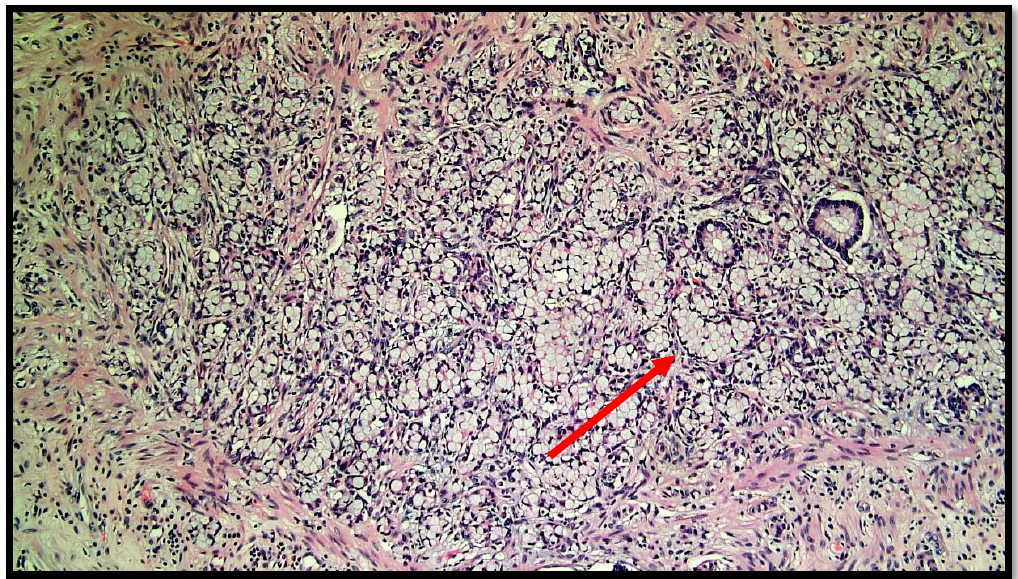
Figure 2. Photomicrograph showing goblet cell carcinoid of the appendix. Cytological detail of the “ ring with bezel ” cells (hematoxylin – eosin, original magnification: 20×). An example of a ring with bezel cells is indicated with a red arrow.